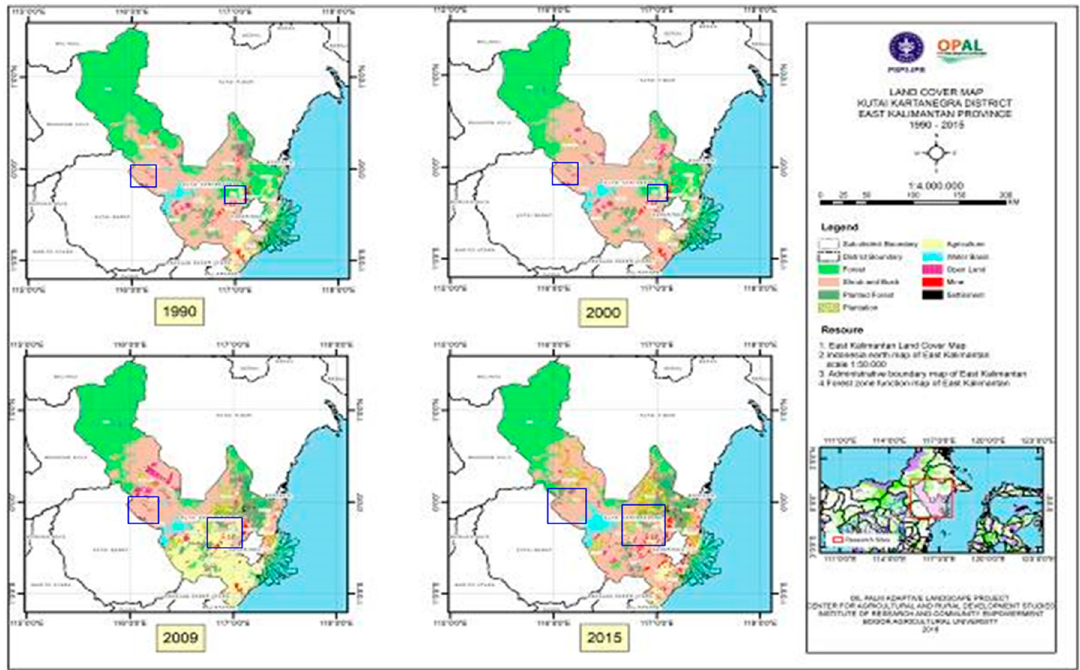
Figure 2. Land-cover changes in Kutai Kartanegara district from 1990 to 2015. Source: Secondary data, processed, 2018.